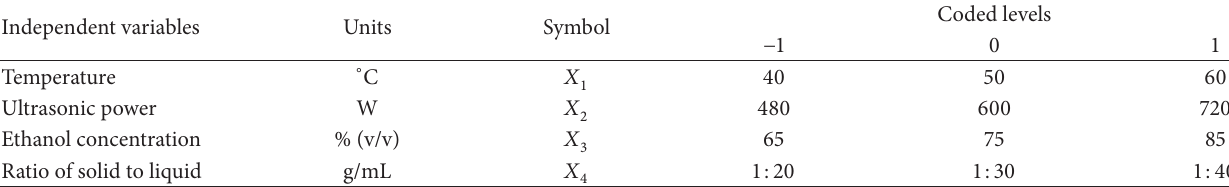
Table 1: Design of factors and levels coded table.